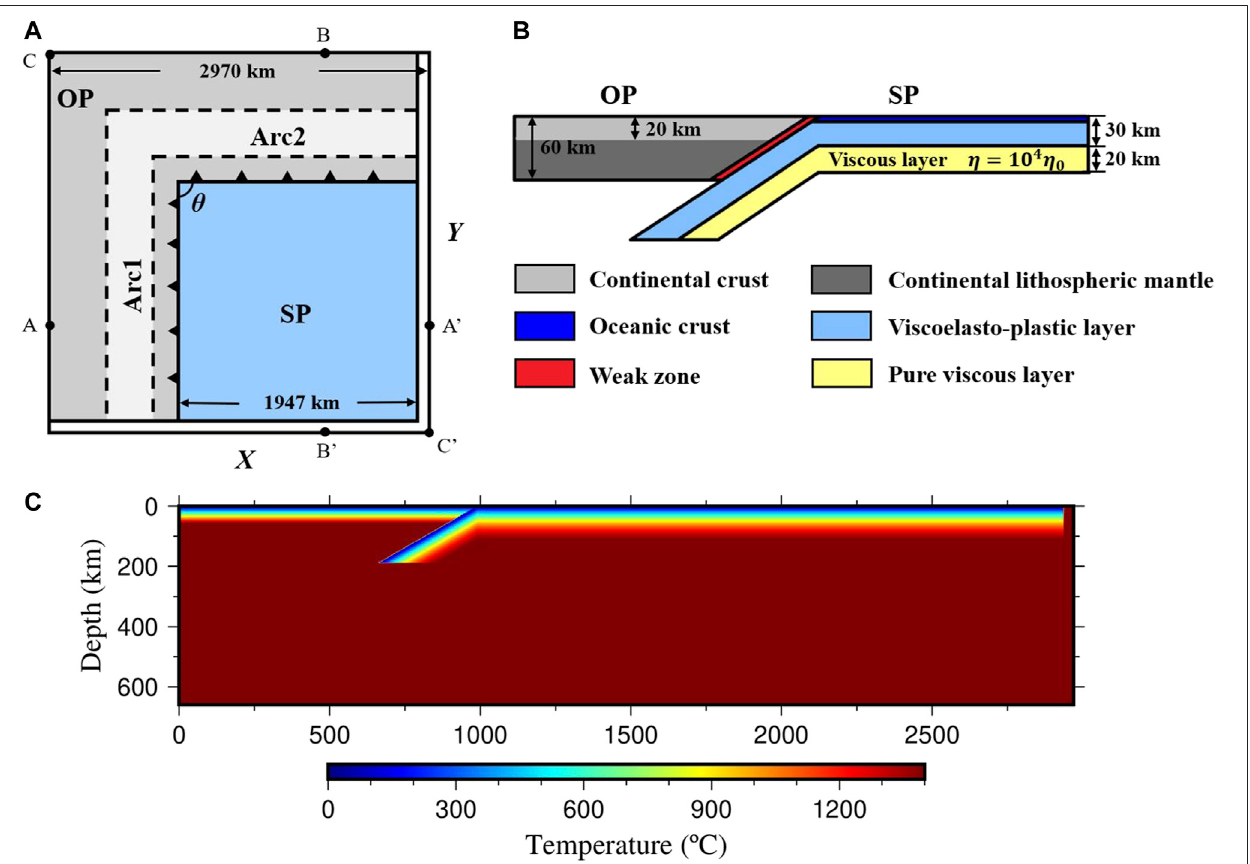
FIGURE2|(A) Topviewofourgeodynamic model, including asubducting oceanic plate and anoverridingcontinentalplate.Weselect pro fi les AA ’ ( Y (cid:1) 1,155 km), BB ’ ( X (cid:1) 1815 km), and CC ’ (diagonal direction) to show slab morphology and quantify the distance of trench migration. θ represents the initial angle of the subduction cusp. (B) Schematic diagram of the compositional fi eld near the trench. On the left is the layered overriding plate (OP), which consists of 20-km-thick continental crust (light gray) and 40-km-thick continental lithospheric mantle (deep gray). On the right is the subducting plate (SP), where deep blue, light blue, and yellow colors represent oceanic crust and two layers of oceanic lithospheric mantle with different rheological properties. The red zone is a weak zone at the interface between the overriding and subducting plates. (C) The initial temperature fi eld of our model along pro fi le AA ’ . We use a linear temperature pro fi le for the overriding continental plate and a half-space cooling model for the subducting oceanic